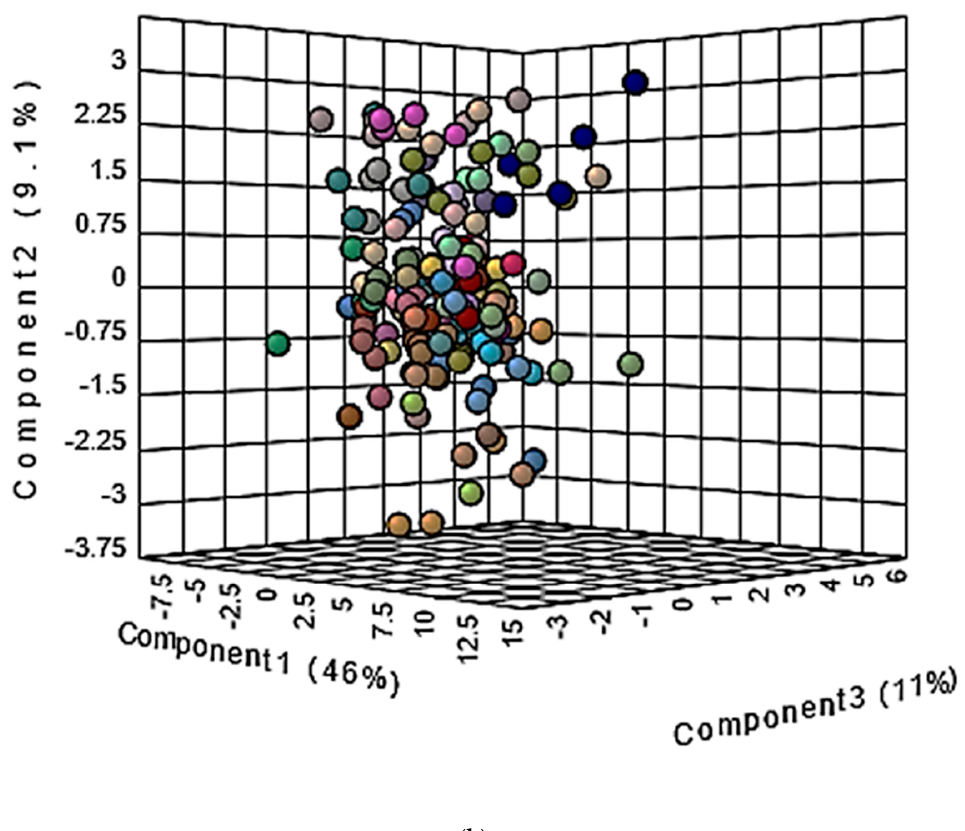
Figure 9. ( a ) Orthogonal T score [1] vs. T score [1] plot for an OPLS-DA model applied to n = 6 randomly selected WMS sample donors only, showing some reproducible phenotypic distinctions between at least some of the study participants (coded as participants 4, 7, 14, 28, 29, and 36). A corresponding PLS-DA model yielded a Q 2 value of 0.44 for a consideration of three orthogonal components, and a permutation test featuring 2000 permutations gave a highly significant p value of 0.007. ( b ) PC3 vs. PC2 vs. PC1 scores plot for a PLS-DA model applied to all sample participants (n = 48), again showing some discrimination between the WMS samples of donors (different colorations correspond to different study participants). Although the maximal Q 2 value obtained was only 0.15 for a six-component model (which unfortunately is also extremely restricted by the very large number of participant classifications used for distinction purposes, i.e., 48), a permutation test involving 2000 permutations gave rise to a very highly significant p value of <5 × 10 − 4 .